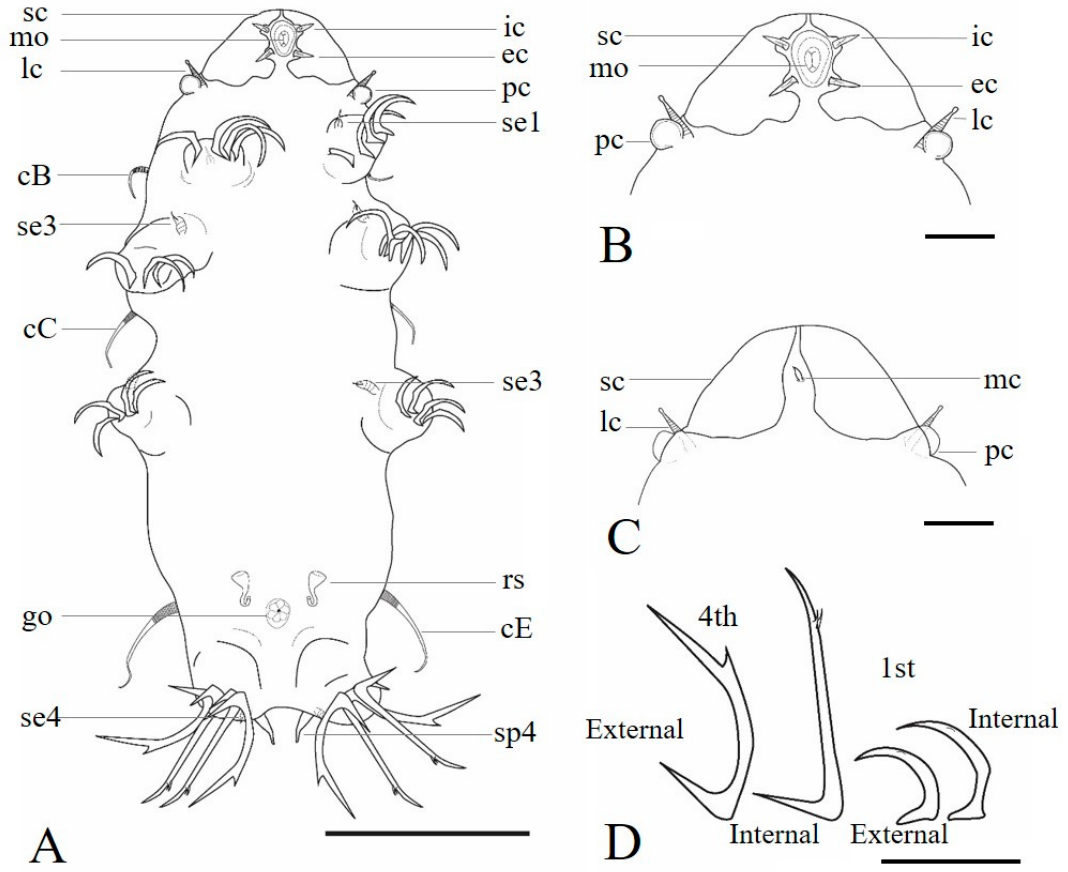
Figure 6. Coronarctus neptunus sp. nov. Drawings based on the holotype. ( A ) Ventral view of the body; ( B ) Dorsal view of the head; ( C ) Ventral view of the head; ( D ) Claws of the first and fourth pairs of legs. Abbreviations: cB—cirrus B , cC—cirrus C ; cE—cirrus E ; ec—external cirrus; go—gonopore; ic—internal cirrus; lc—lateral cirrus A ; mc—median cirrus; mo—mouth; pc—primary clava; rs—seminal receptacle; sc—secondary clava; se1–4—sensory organ legs I–IV; sp4—coxal process on leg IV. Scale bars: A-50 µm, B–D-10 µm.